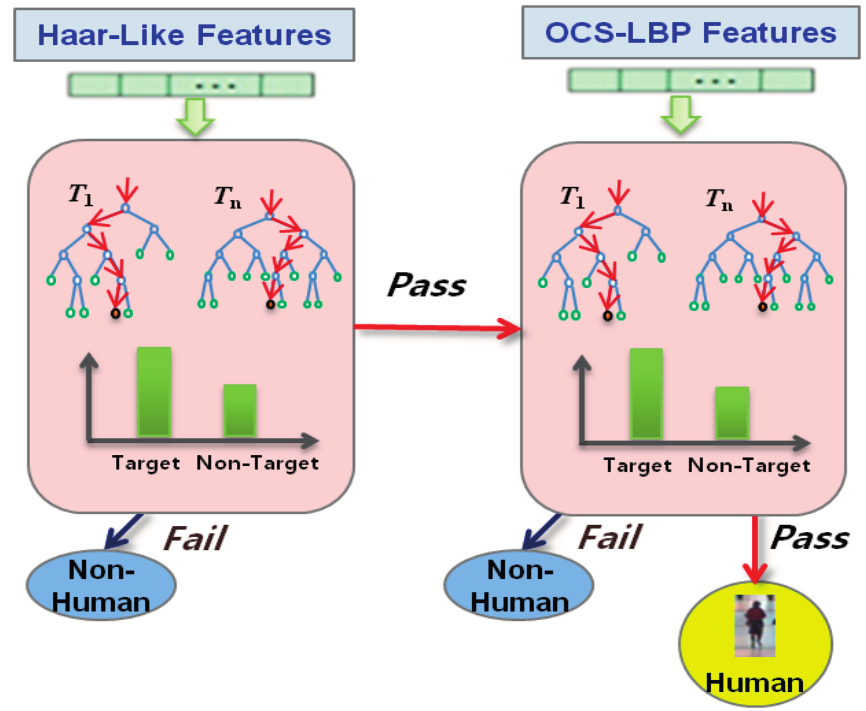
Figure 3. The structure of the two-level CaRFs using Haar-like features and OCS-LBP descriptors. If the candidate window passes through two random forests, it is declared as the final human